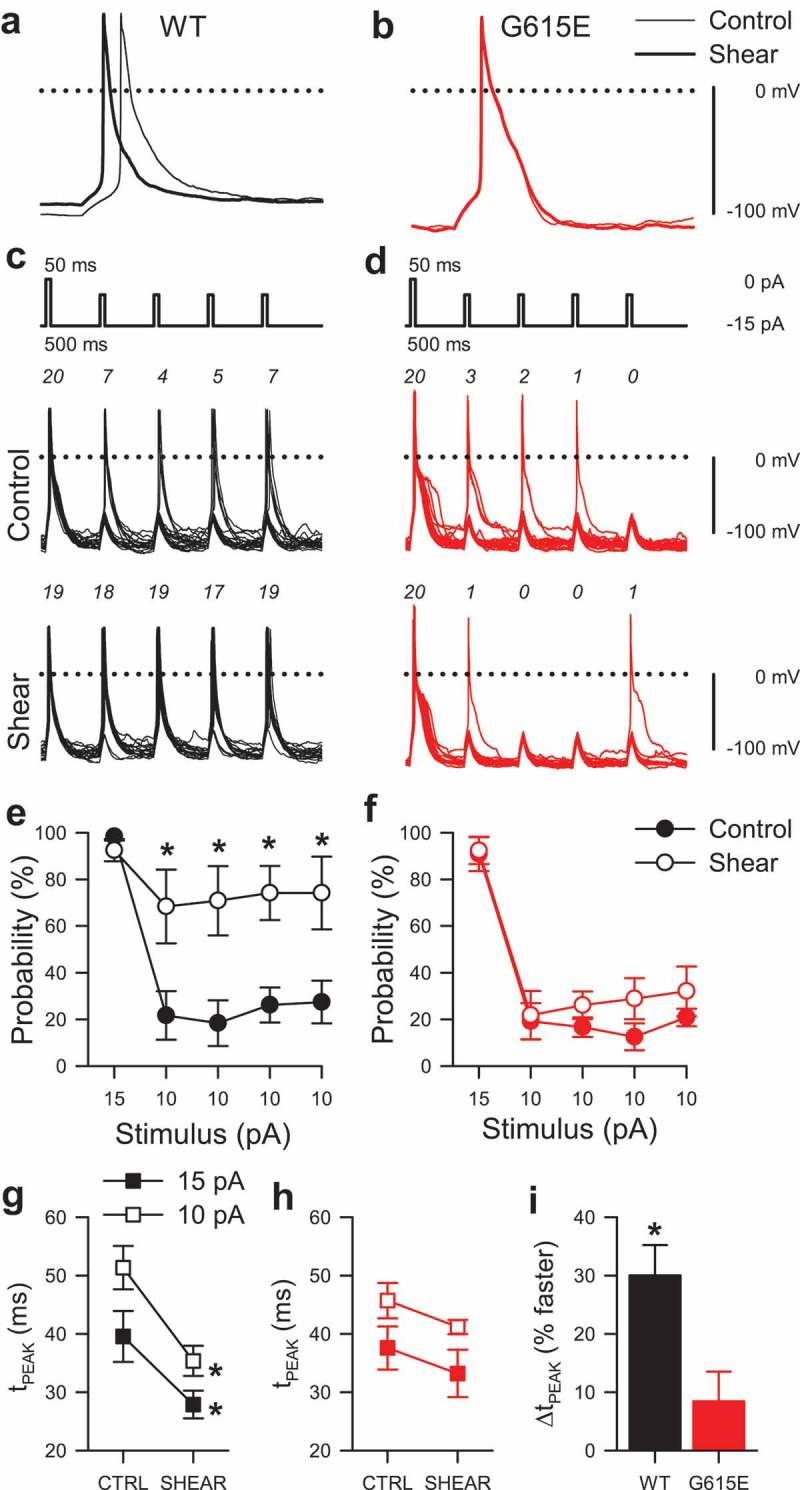
Mechanosensitivity of WT and G615E NaV1.5-induced elicited electrical excitability. (a-b), Potentials evoked by a 50-ms current stimulus before (–) or during (▬) shear stress from HEK293 cells expressing either WT (a) or G615E (b) NaV1.5 channels. (c-d), 20 overlapping sweeps of potentials from WT (c) or G615E-NaV1.5 (d) transfected HEK cells, induced by a current stimulus protocol (inset) with one super-threshold (Δ15 pA) 50-ms stimulus followed by four sub-threshold 50-ms stimuli (Δ10 pA), before (control) or during (shear) mechanical stimulation. (e-f), Fraction of potentials from WT (e) or G615E-NaV1.5 (f) transfected HEK cells evoked at the super-threshold 15-pA stimulus or four sub-threshold 10-pA stimuli before (●) or during (○) application of shear stress (n = 6 cells each; *P < 0.05 WT control vs. WT shear and P < 0.05 interaction between stimulus, genotype, and shear by a three-way ANOVA with Tukey post-test). (g-h), Time to peak potential (tPEAK) from cells expressing WT (g) or G615E-NaV1.5 (h) channels evoked at the 15-pA (■) or 10-pA (□) stimulus before (CTRL) or during shear stress (SHEAR) (n = 6 cells each; *P < 0.05, WT control vs. WT shear; P < 0.05, effect of stimulus or effect of shear; and P < 0.05, interaction between genotype and shear by a three-way ANOVA with Tukey post-test). (i), Average change in time to peak potential (ΔtPEAK) induced by shear for WT (black) or G615E-NaV1.5 (red) (n = 6 cells each; *P < 0.05% to 0% by a two-tailed one-sample t-test).